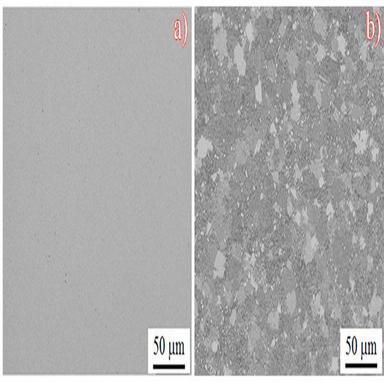
Optical micrographs of the HIPed superalloy in a) as-polished condition revealing porosity free structure and b) etched condition revealing equiaxed microstructure.